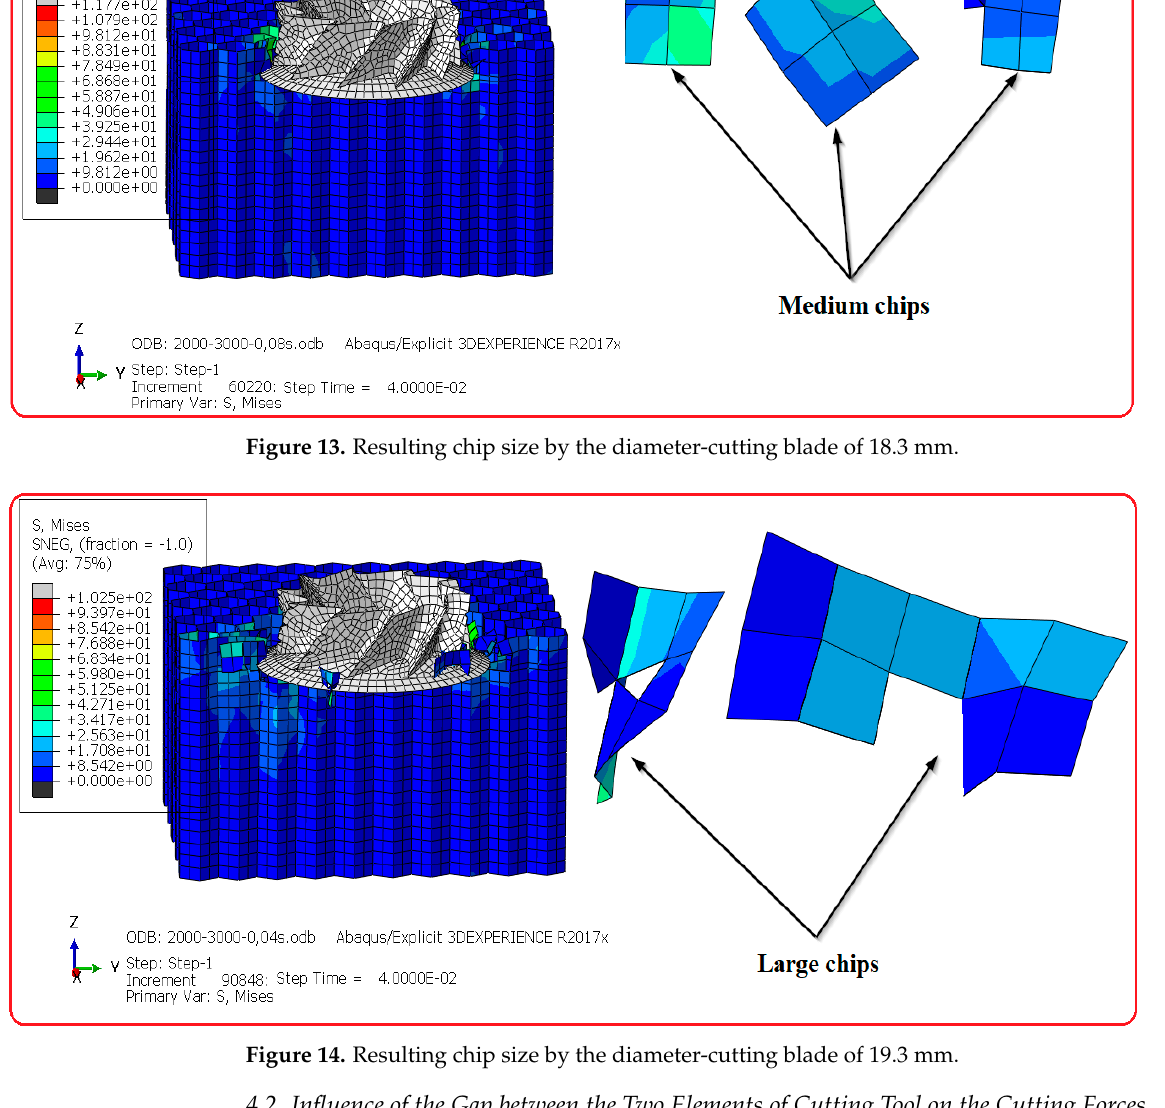
Figure 14. Resulting chip size by the diameter-cutting blade of 19.3 mm.